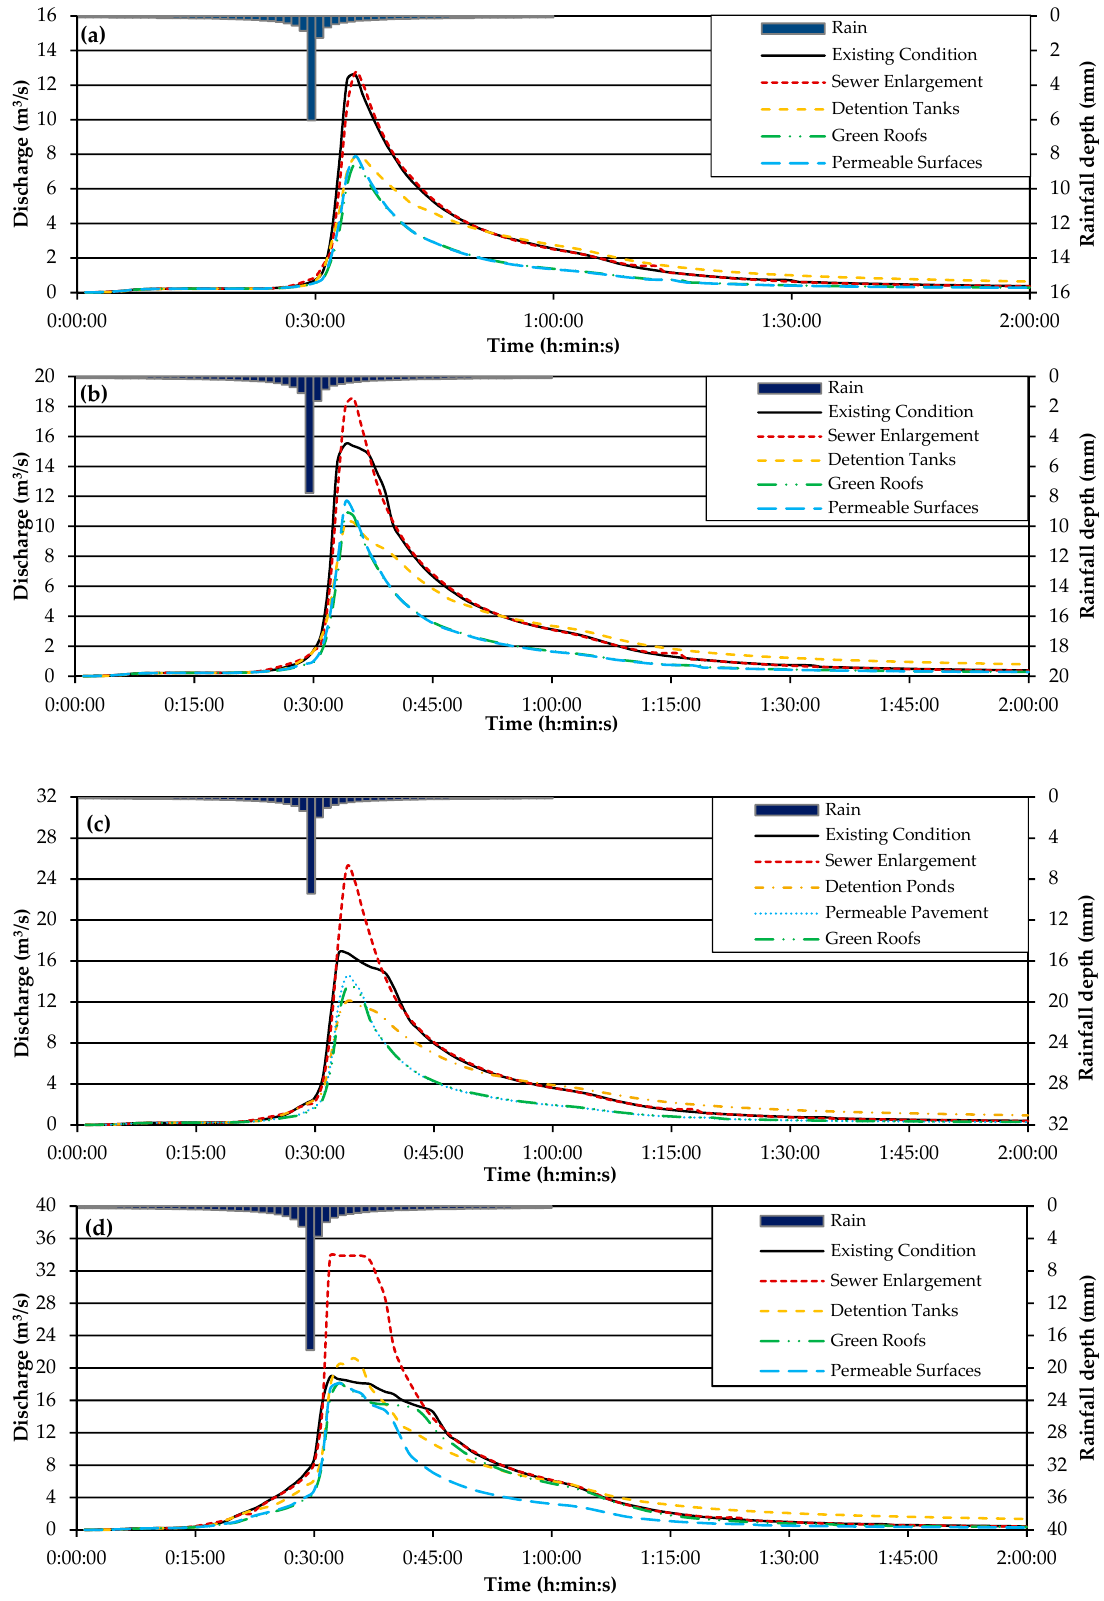
Figure 2. Hydrographs of 1-h duration storm at the outlet of the study area for all the scenarios tested, and for return periods of: ( a ) 2 years; ( b ) 5 years; ( c ) 10 years; and ( d ) 100